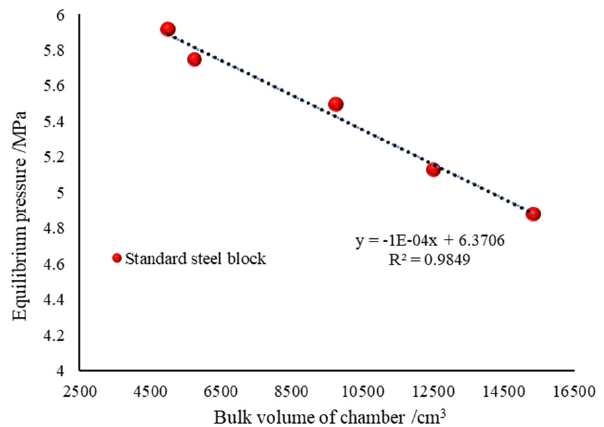
Figure 5. The fitting curve between the bulk volume of the chamber and equilibrium pressure.